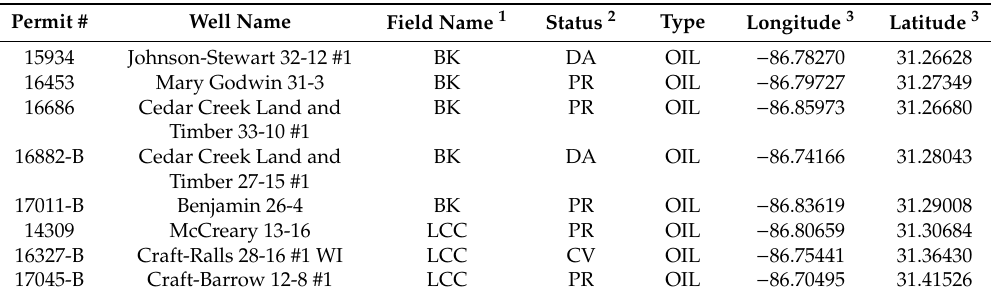
Table 2. List of the wells used for this